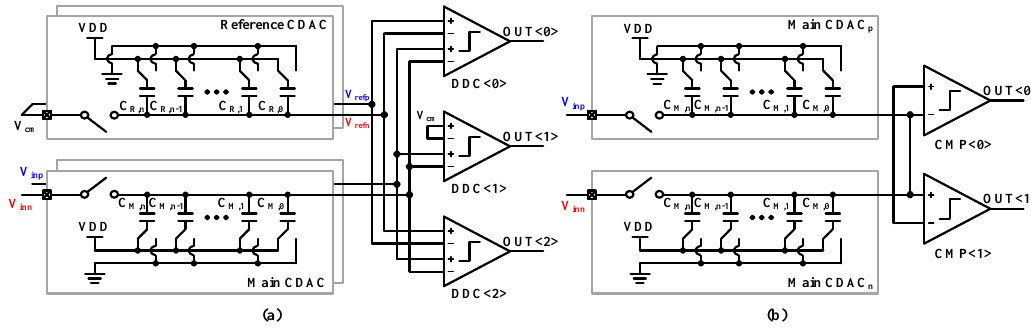
Figure 7. Block diagram of ( a ) the sub-channel 2b/cycle SAR ADC and ( b ) window detector SAR ADC.